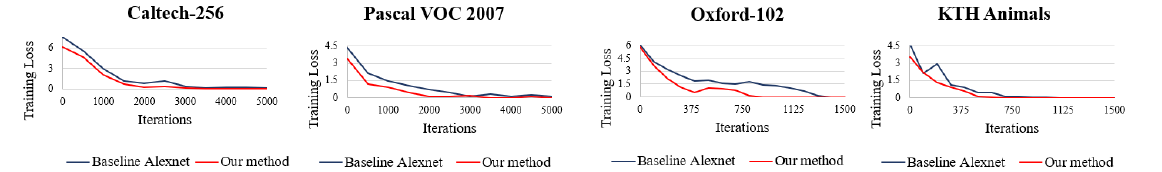
Figure 7. Learning curve (training loss vs. iterations) for the baseline Alexnet and the proposed method. Apparently, our approach converges faster during the training stage since domain knowl- edge embedded handcrafted features provide effective learning